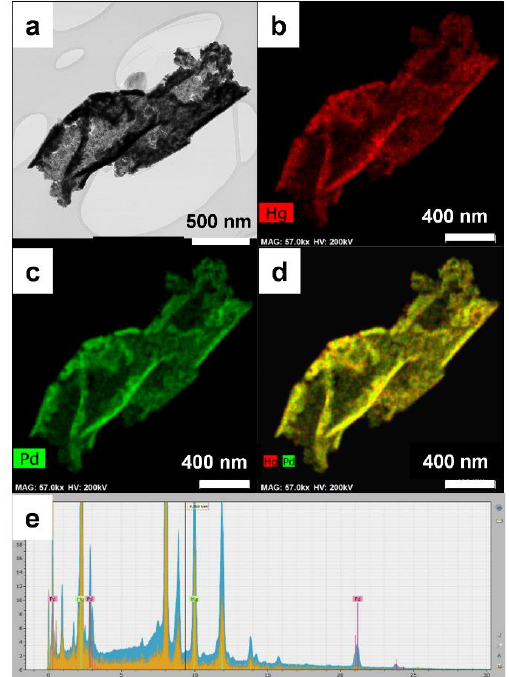
Figure 7. TEM and HAADF of peeled Pd 2 Hg 5 amalgam from the surface of glassy carbon: ( a ) TEM, ( b ) HAADF Hg, ( c ) HAADF Pd, and ( d ) HAADF for Pd and Hg, and ( e ) ED analysis of prepared PdHg800.